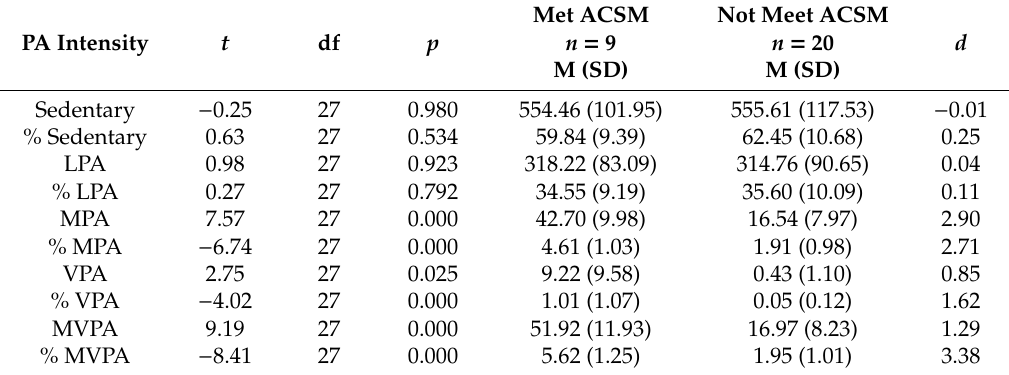
Table 4. Independent samples t -test values and e ff ect sizes ( d ) for o ff -duty PA intensities for firefighters meeting and not meeting ACSM